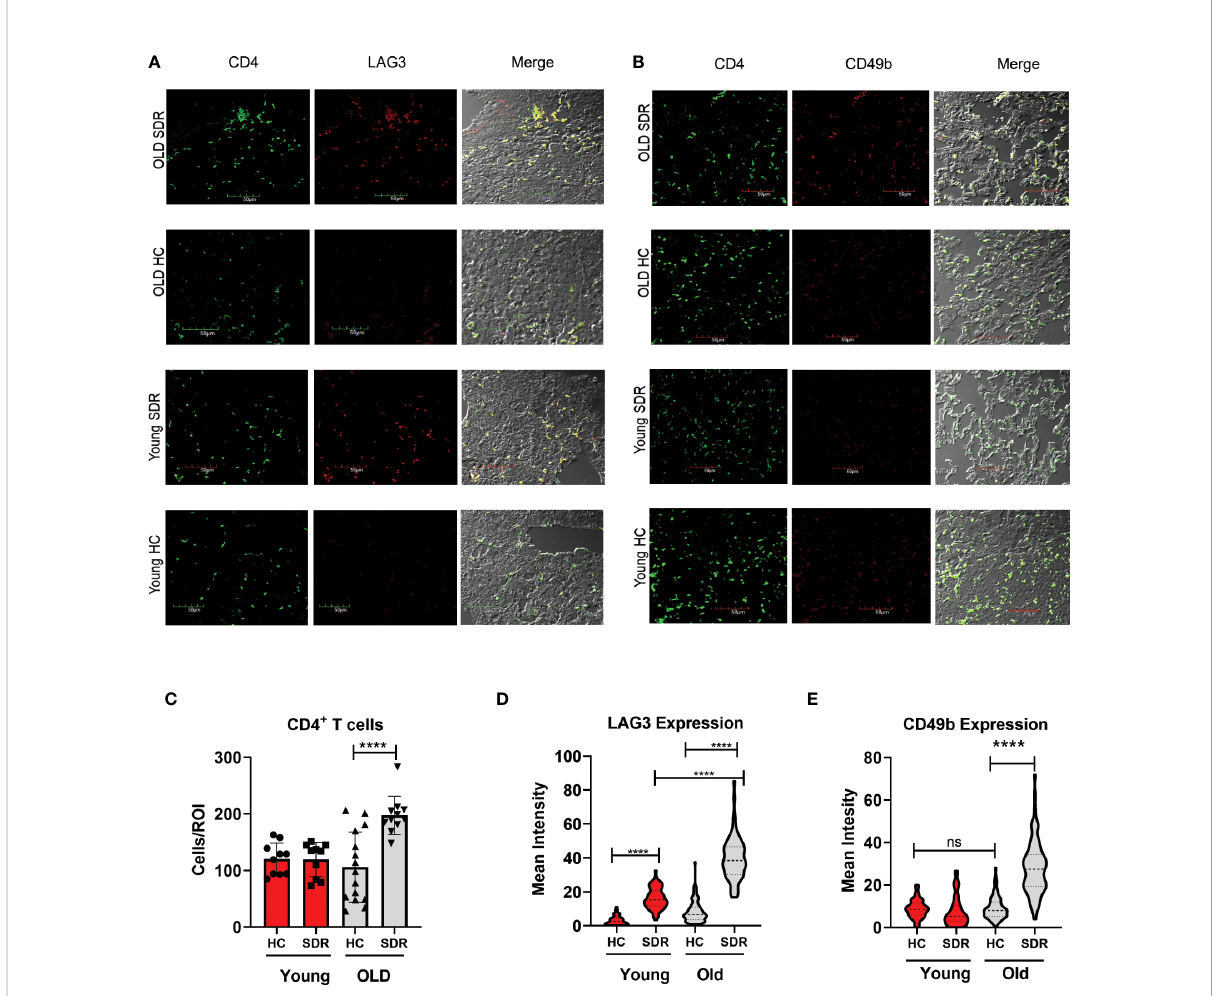
FIGURE 7 SDR in old mice up-regulate expression of LAG3 and CD49b in CD4 + T cells (A) Representative images of LAG3 expression in CD4 + T cells present in regions of pneumonia (B) Representative images of CD49b in CD4 + T cells. (C) Granulomatous tissue in old SDR mice contain more CD4 T cells. CD4 T cells were counted in regions of granulomatous tissue. Each symbol represents a region of granulomatous tissue. N=15 regions/group. Mean fl uorescence intensity of LAG3 (D) and CD49b (E) expression in CD4 T cells was determined using Image (J) N= 90 cells/group. Statistical analysis was performed by one-way ANOVA with Tukey multiple-comparisons post hoc test. **** p < 0.0001. ns, non signi fi